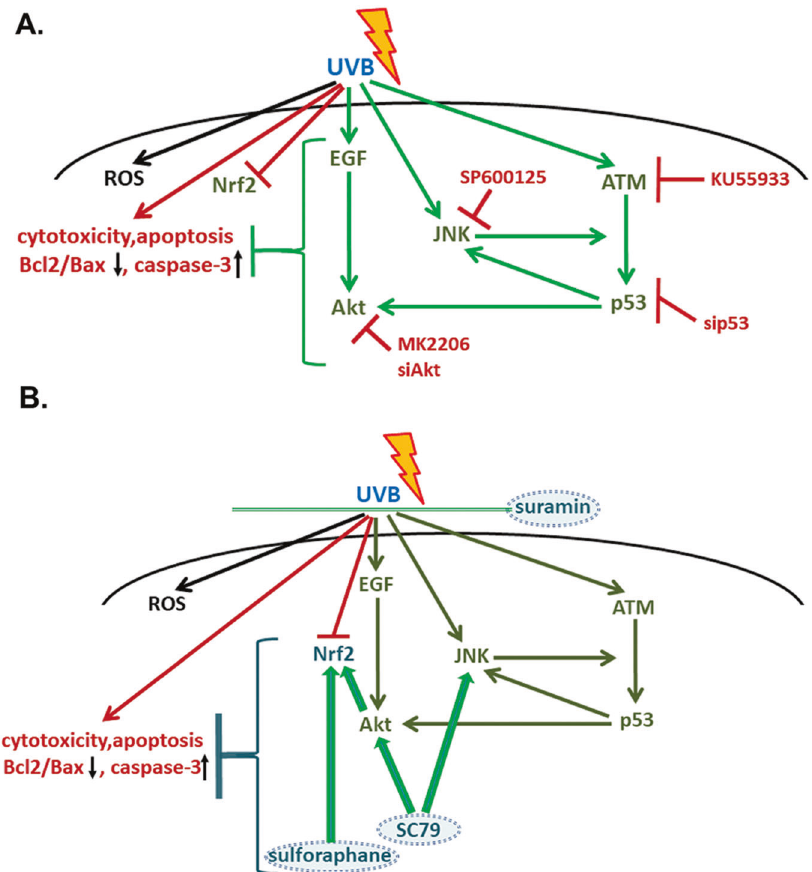
Fig. 8 Proposed model of the UVB-triggered biochemical pathways in human dermal fi broblasts. A UVB-induced inherent cellular responses. UVB radiation leads human dermal fi broblasts to apoptosis in vitro and in vivo. UVB treatment induces in parallel the EGFR-Akt signaling pathway and the JNKs MAPKs which intervene with the phosphorylation of p53, part of the ROS-independent DNA damage response of the cells towards UVB genotoxicity. EGFR-Akt, JNKs, and ATM-p53 pathways seem to co-operate for the protection towards UVB radiation and the retention of a suf fi cient percentage of viable cells in the exposed population. This is evidenced by the increased loss of viability after Akt inhibition or siRNA-mediated knocking-down and the unmitigated cell death when directly (or indirectly through JNKs inhibition) impeding the activation of the ATM-p53 pathway. B Interplay of exogenously supplied photoprotective molecules with the intrinsic UVB-induced machinery to amplify the resistance of human skin fi broblasts against UVB radiation. Whereas the known anti-oxidant Trolox does not increase cell survival rate after UVB exposure, extra protection is conferred by other exogenously supplied molecules: suramin acts as a UV shield; EGF activates EGFR; SC79 enhances inherent cellular response (i.e., it activates further Akt and JNKs) and triggers Nrf2 activation downstream of Akt; sulforaphane induces Nrf2 activation independent of the Akt or JNKs signaling pathways. Nrf2-mediated protection by SC79 and sulforaphane is not based on ROS-scavenging and can be attributed to the transcription factor ’ s ability to safeguard genome integrity or to produce a protective extracellular